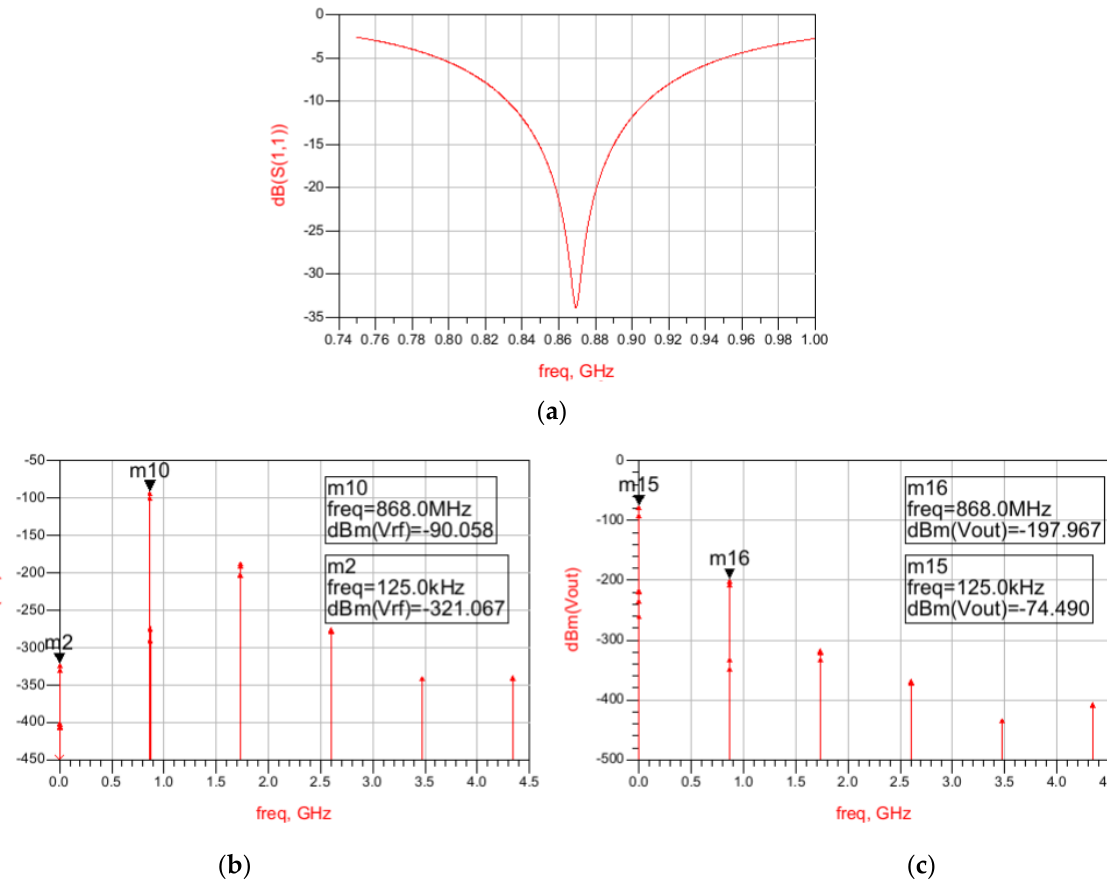
Figure 10. Input Return Loss simulation results of the current-reuse feedback WuR with amplification and low-pass filtering stages and harmonic balance simulation results. Input Return Loss of the circuit ( a ), harmonic balance AM input signal ( b ), and WuR’s output signal ( c ).